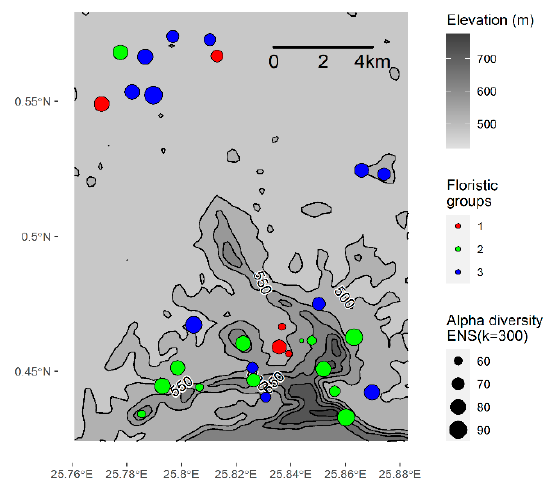
Figure 1. Distribution of one-hectare plots along an altitudinal gradient. Dots represent 1-ha plots; dot sizes are proportional to alpha diversity and colors represent plots within the same k -means derived groups.